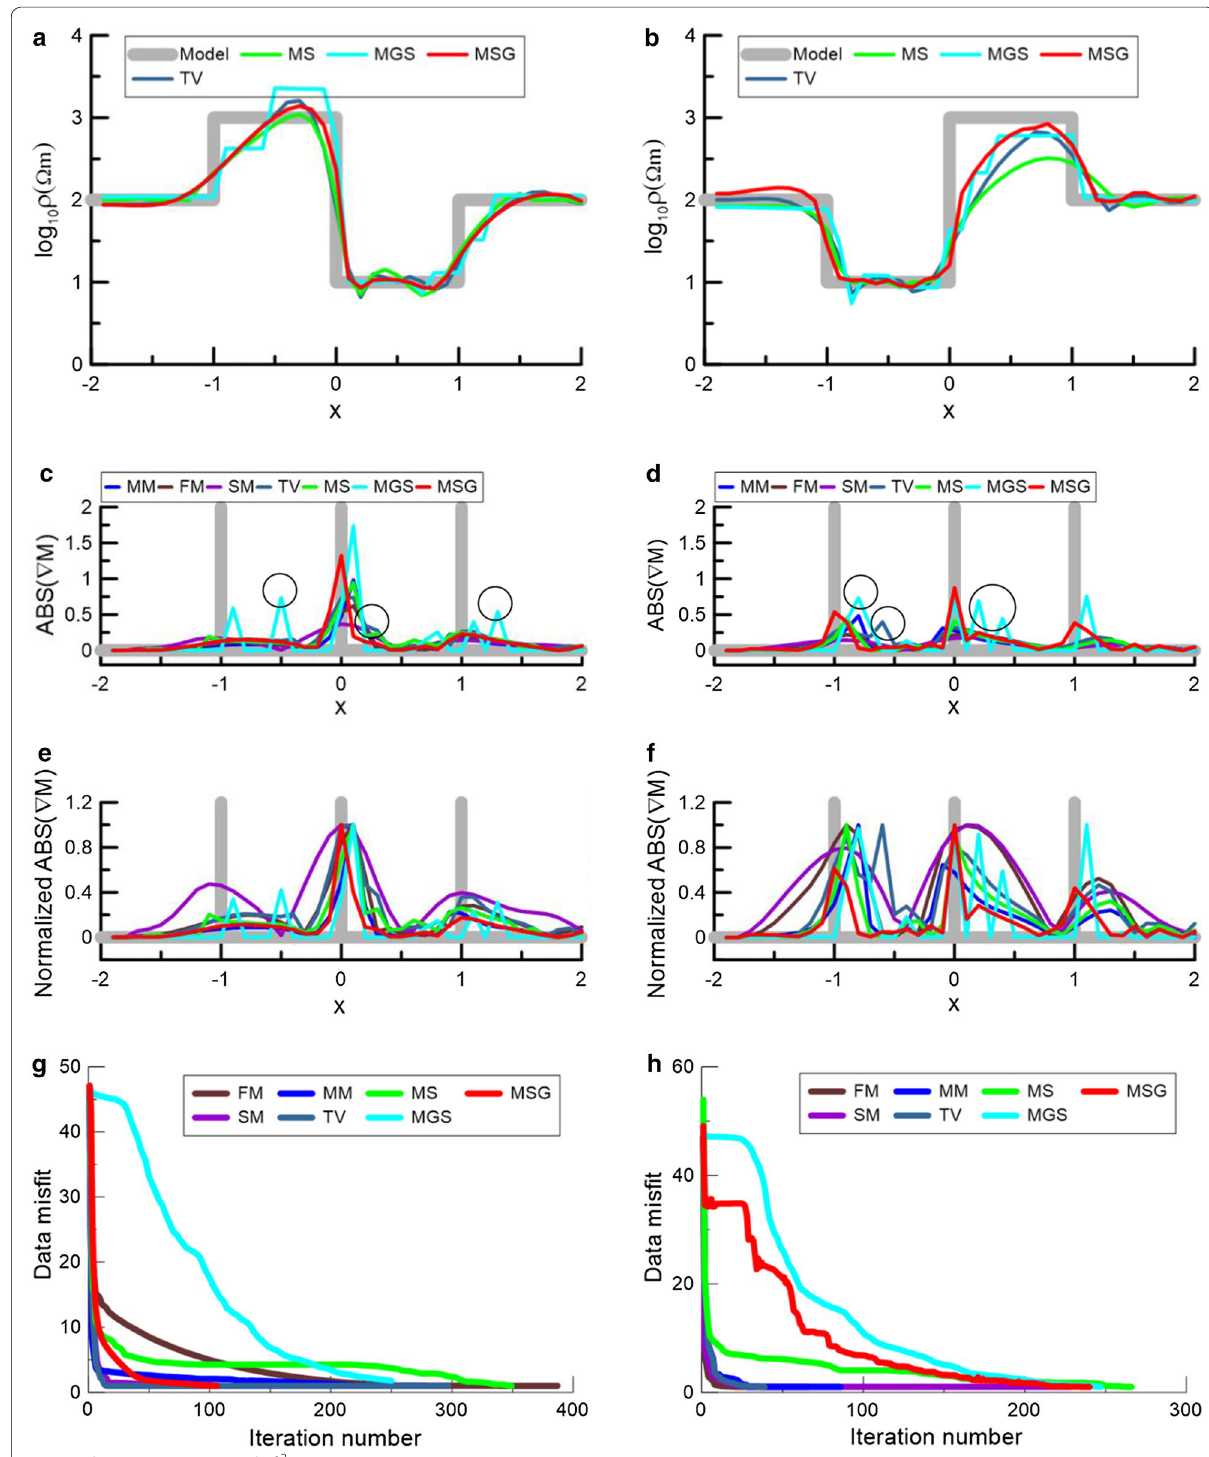
Fig. 5 The same as Fig. 3 with β 2